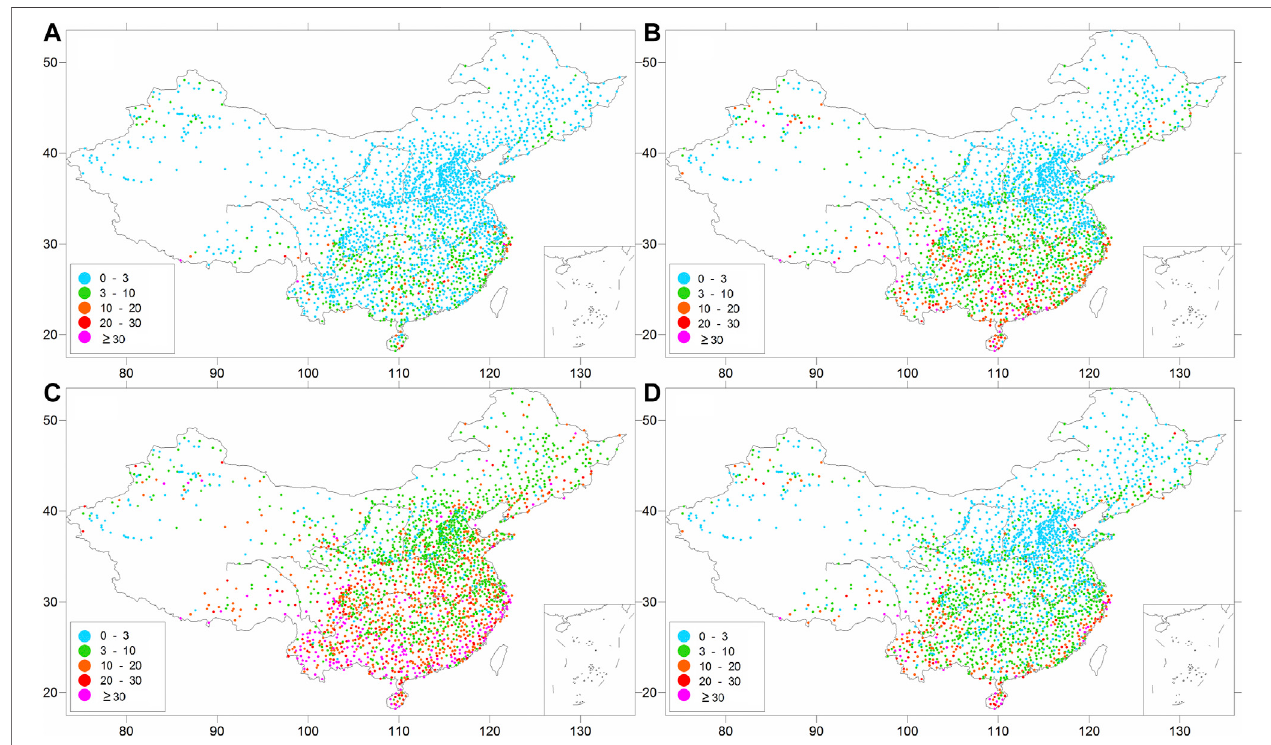
FIGURE 3 | Spatial distributions of the MAE for the climatology values (unit: mm/month) in (A) DJF, (B) MAM, (C) JJA, and (D) SON.